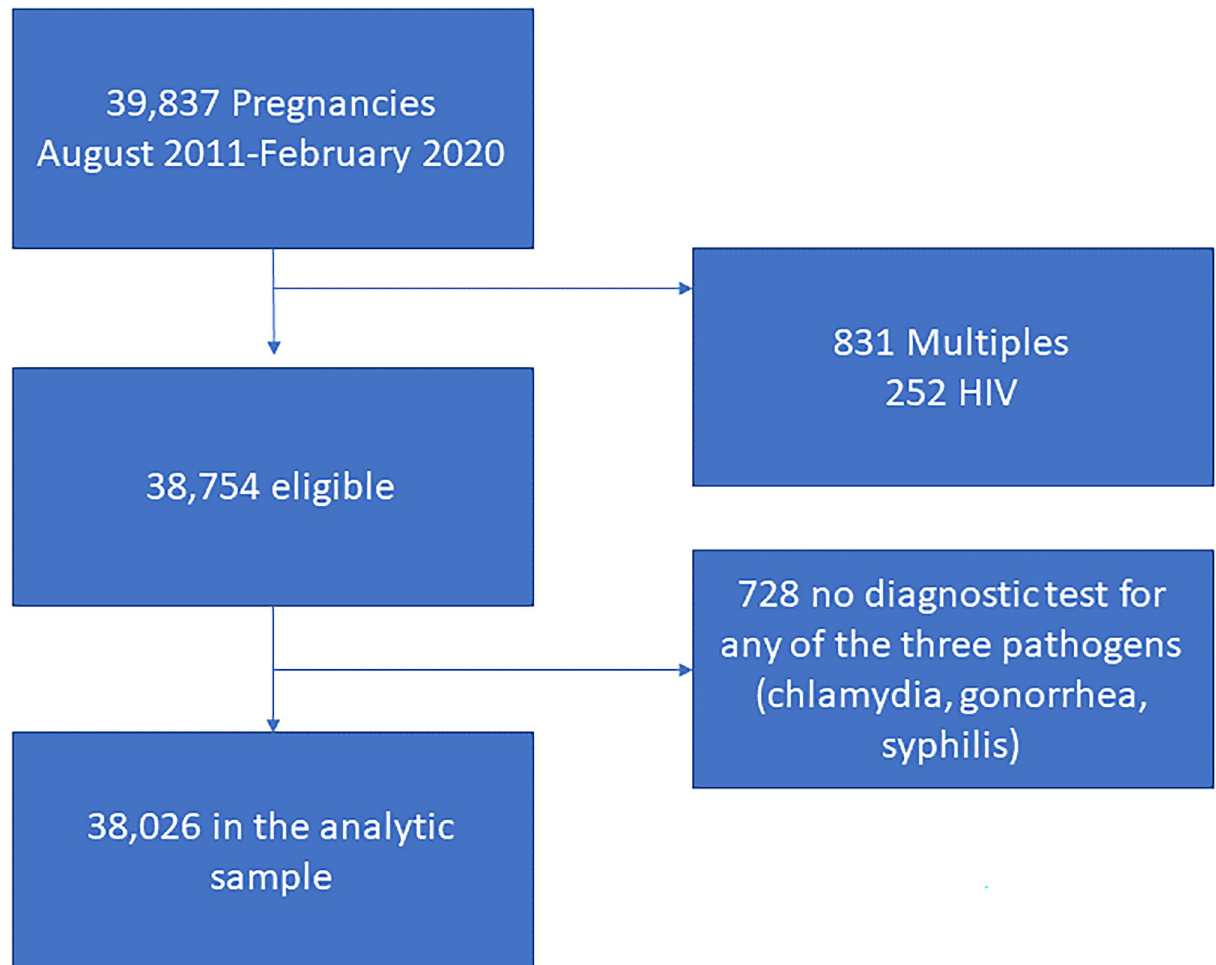
Figure 1. Flow diagram of sample size by exclusion